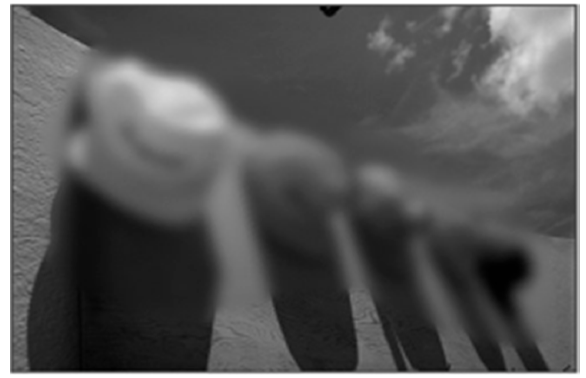
Figure 6. Damaged figure of interest region.